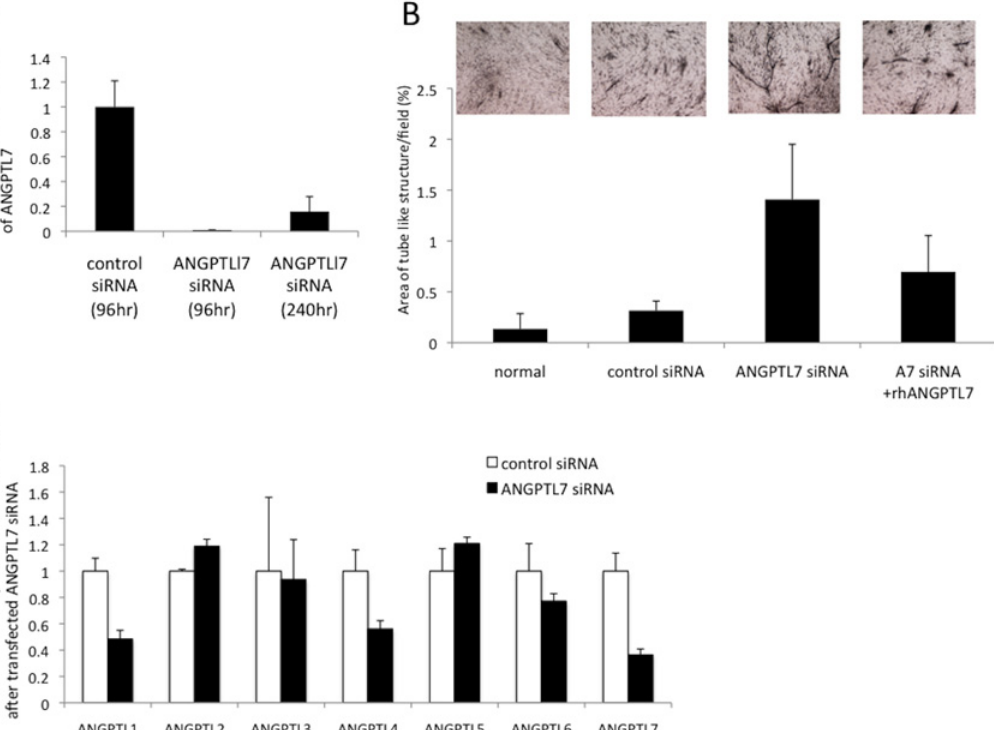
Figure 4. ANGPTL7 siRNA tranfection increased tube formation in HCK-HUVEC co-culture. ANGPTL7 mRNA expression was drastically inhibited following the administration of ANGPTL7 siRNA for up to 240 h after transfection (A). The tube-formation areas under the normal serum-free medium (normal) and control siRNA treatment were 0.13 ± 0.15% and 0.31 ± 0.09%, respectively (B). In the cells transfected with the ANGPTL7 siRNA the tube formation areas increased significantly (1.41 ± 0.54%, p < 0.001, B). This siRNA effect was potently suppressed when human recombinant ANGPTL7 (A7 siRNA+rhANGPTL7) was added to the cells (0.69 ± 0.30%, p < 0.001, B). N = 12 per condition. In the cells in which ANGPTL7 expression was suppressed, the mRNA expression levels of ANGPTL1 and ANGPTL4 were also decreased (by 48.4% and 56.1%, respectively), but the expression of ANGPTL2 was increased (119%). N = 2 per each